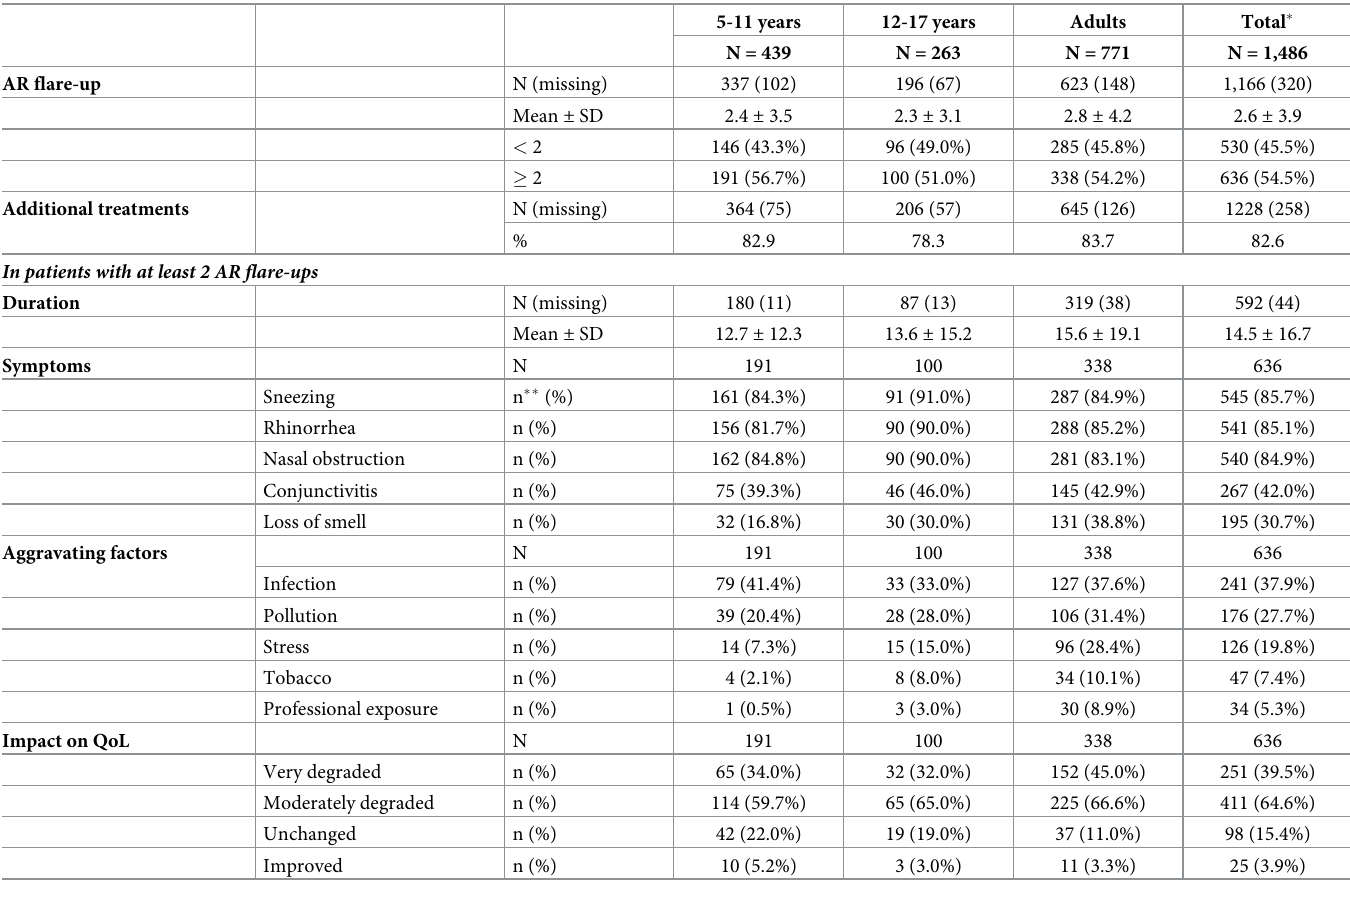
Table 3. Description of AR flare-ups by age group in the last 12 months according to the patient’s